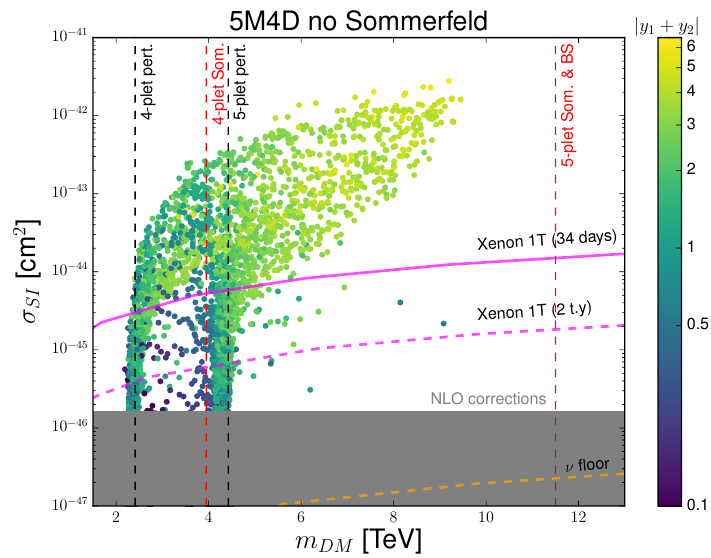
Figure 13. (cid:27) SI in the 5M4D case for an explicit integration of the dark matter abundance with micrOMEGAs in the SU(2) L -broken limit as in (cid:12)gure 8. All points give rise to (cid:10) h 2 gray zone is expected to be strongly a(cid:11)ected by NLO corrections as in this zone (cid:27) SI < 1 : 6 10 (cid:0) 46 cm 2 = (cid:27) NLO computations. The vertical black dashed lines indicate the DM mass obtained SI; 4 (cid:0) plet in the SU(2) L symmetric limit for the pure 4-plet and 5-plet case without sommerfeld corrections. The red dashed lines include the Sommerfeld correction for the 4-plet and the Sommerfeld + Bound state e(cid:11)ects from [22] in the 5-plet case. The continuous magenta line denote the current constraints from the Xenon 1T experiment [59] and the magenta line shows the reach prospects for the same experiment [9]. The dashed orange line shows the \discovery limit" from